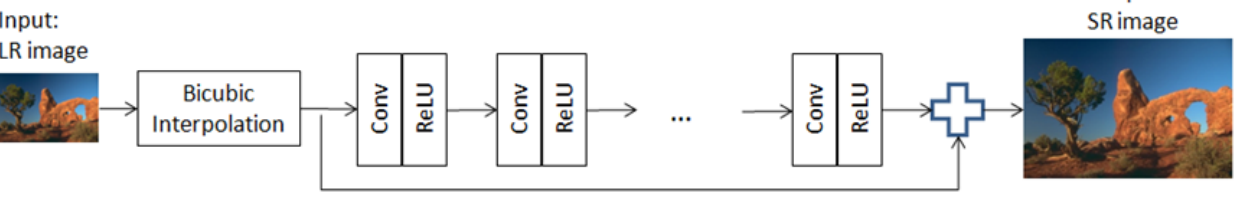
Figure 2. Flow for producing SR images using VDSR.